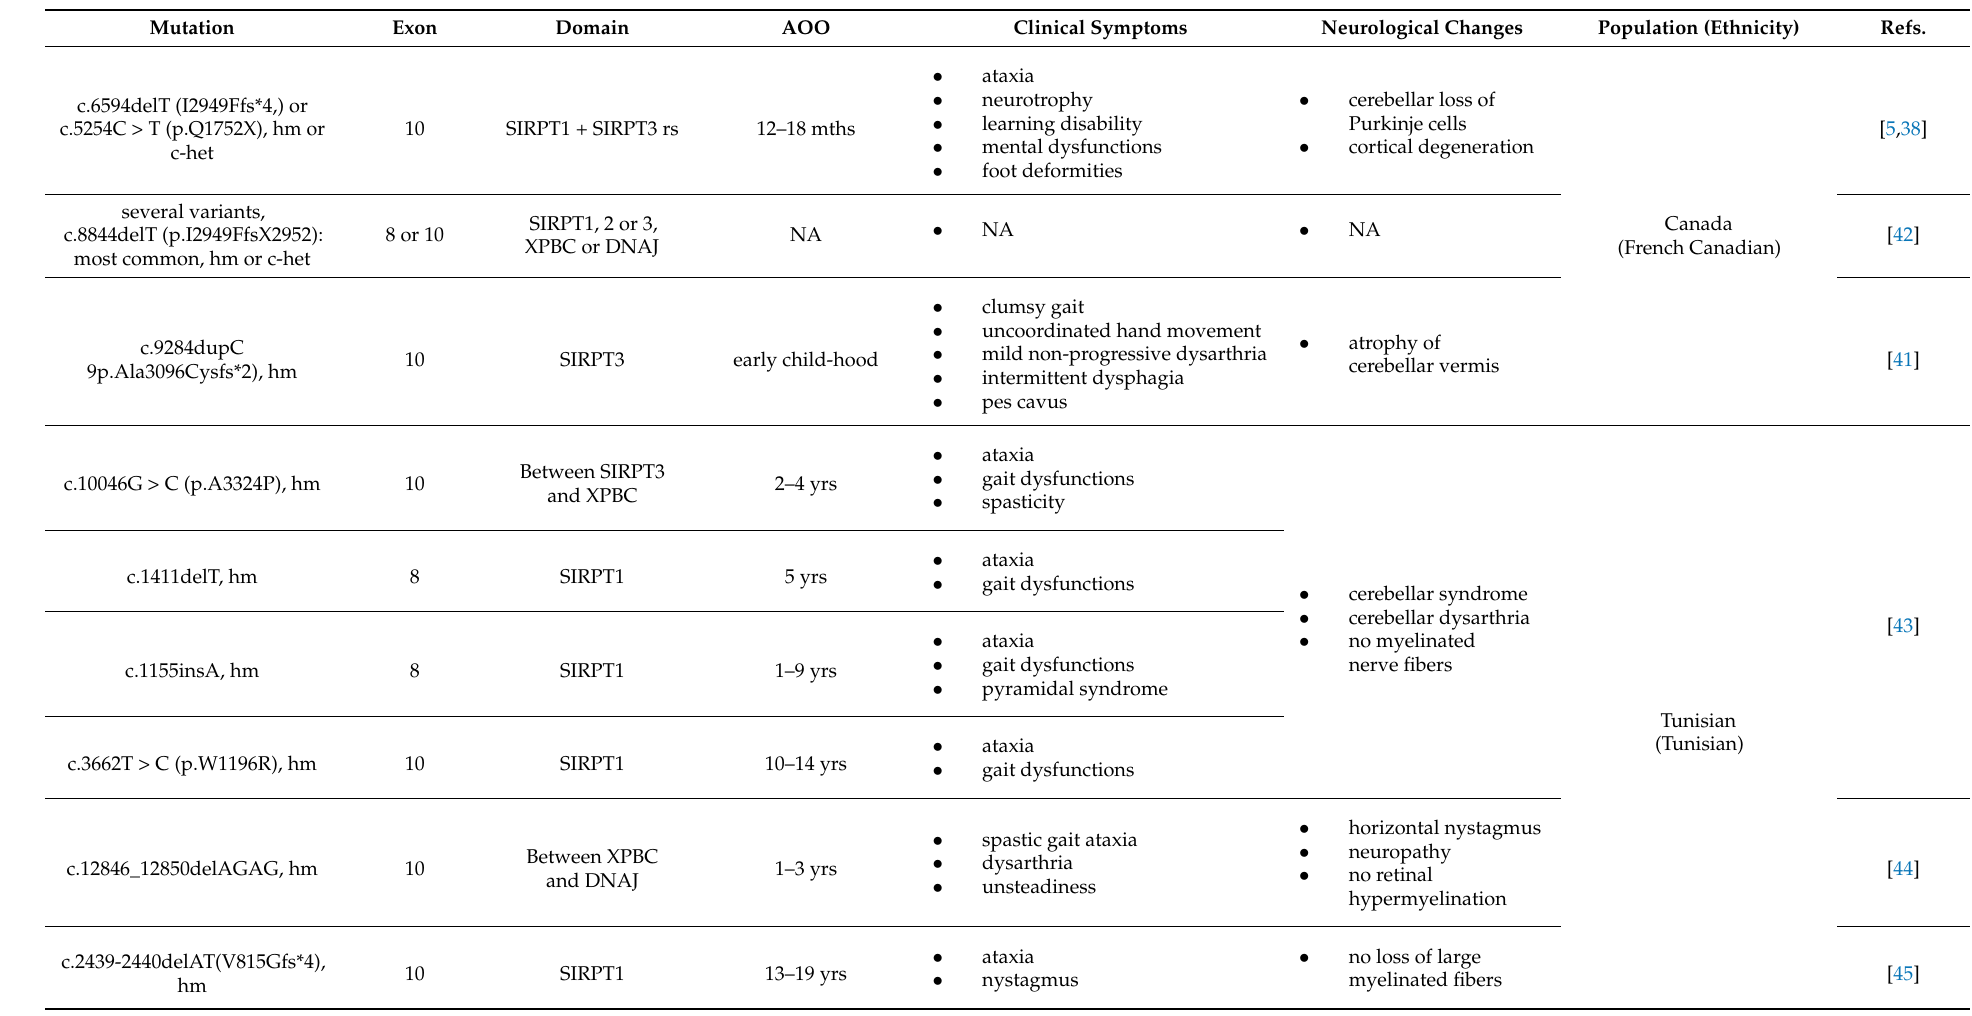
Table 1. SACS mutations detected in French Canadian and Tunisian patients. “hm” means mutation carried the homozygous form, “c het” means mutation had compound heterozygous allele. “rs” means